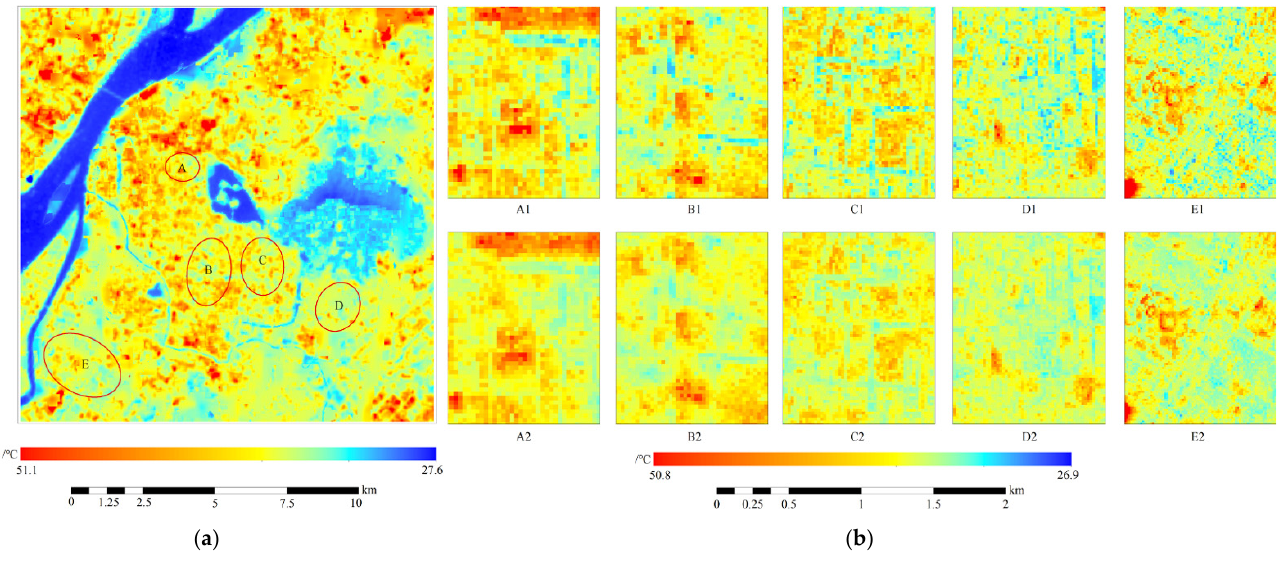
Figure 8. Spatial distribution of the downscaled LST at the resolution of 30 m in five localities of the study area (in b , A1–E1 refer to the downscaled LST from SSRFD, and A2–E2 refer to the downscaled LST from SSRFD-M). ( a ) Landsat LST. ( b ) the downscaled LST for representative 5 local area.